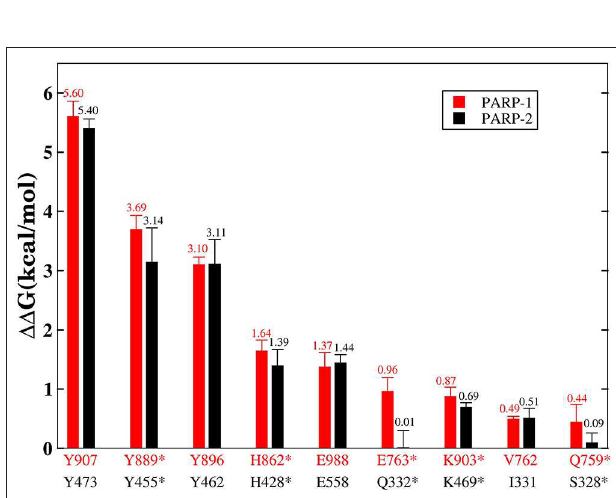
FIGURE 7 | The residues that contributed the most to the binding free energy in PARP-1 and PARP-2. Red represents the residue in PARP-1 and black represents the residue in PARP-2. Stars indicate statistically significant difference ( t -test, p -value <